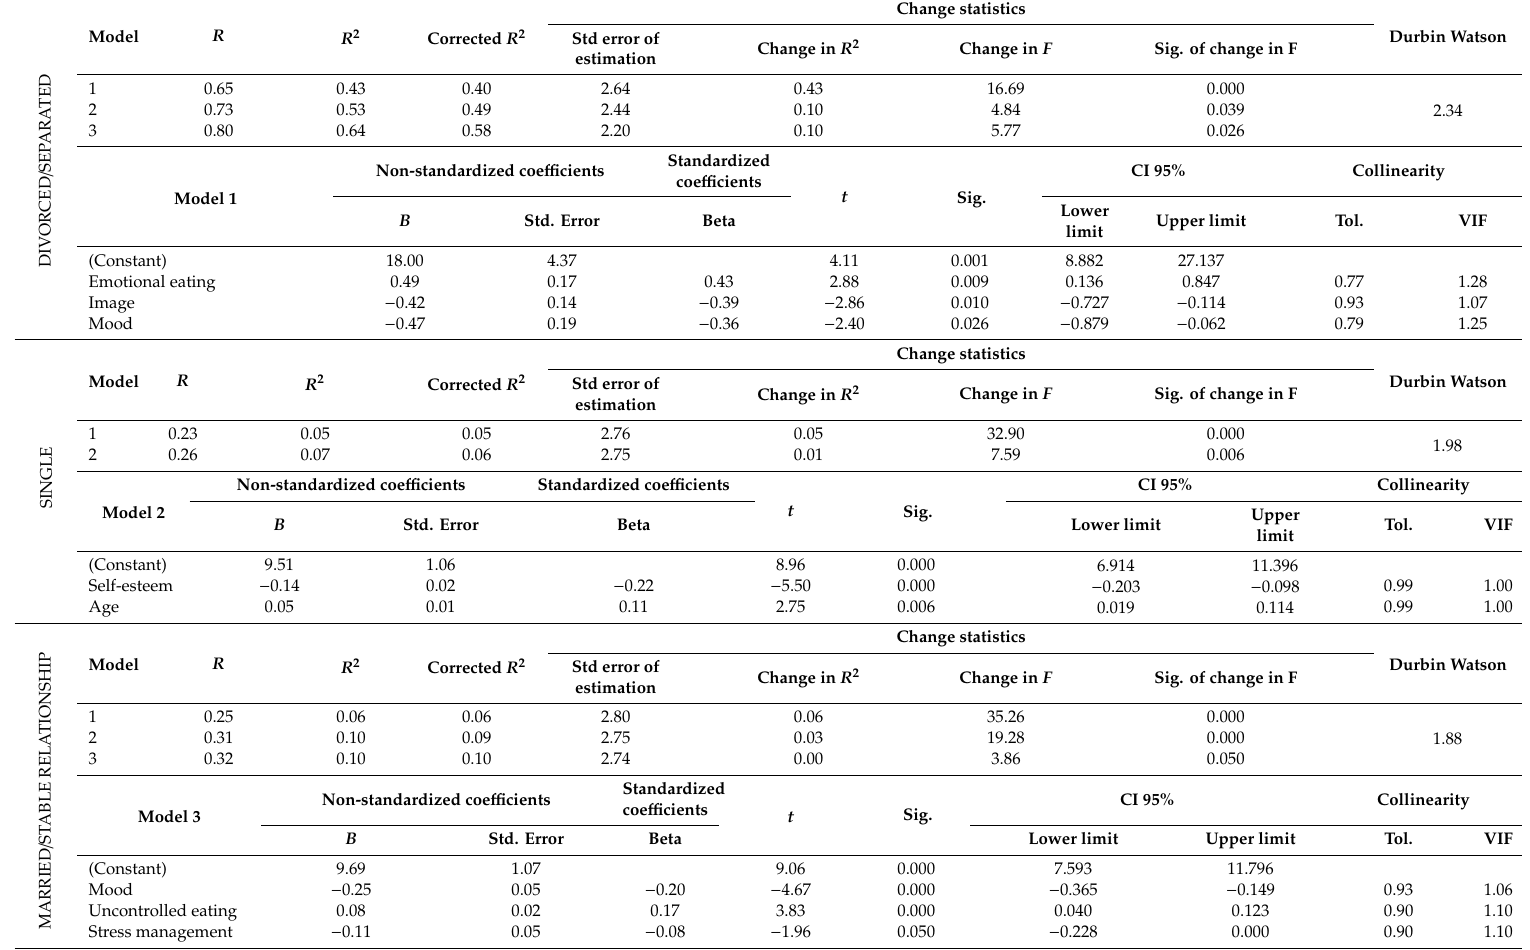
Table 3. Stepwise multiple linear regression model (sleep quality) according to marital